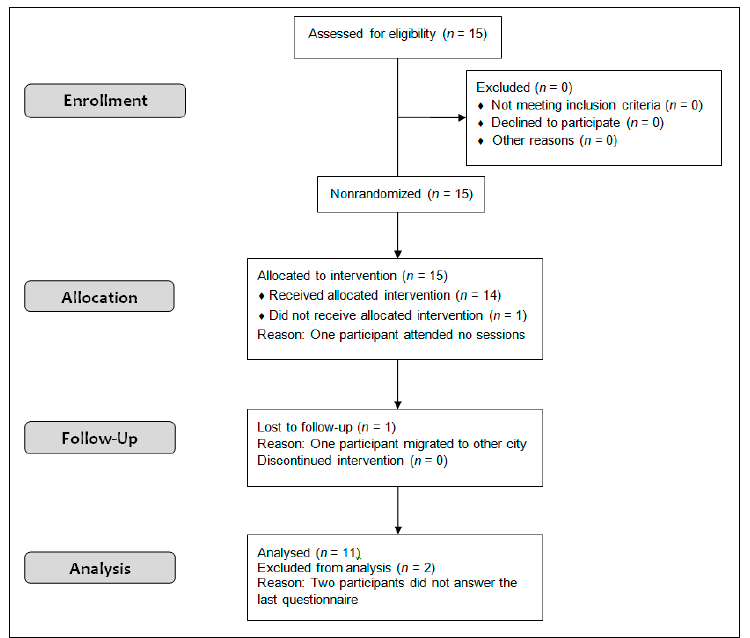
Figure 1. Flow chart of the Transparent Reporting of Evaluations with Non-randomized Designs (TREND) shows the number of participants through each stage of the study.